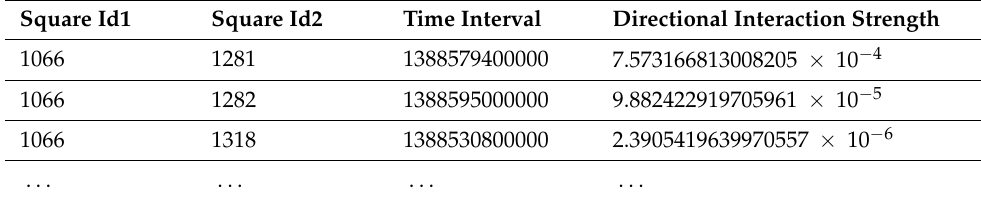
Table 1. Examples of the spatial interaction records.